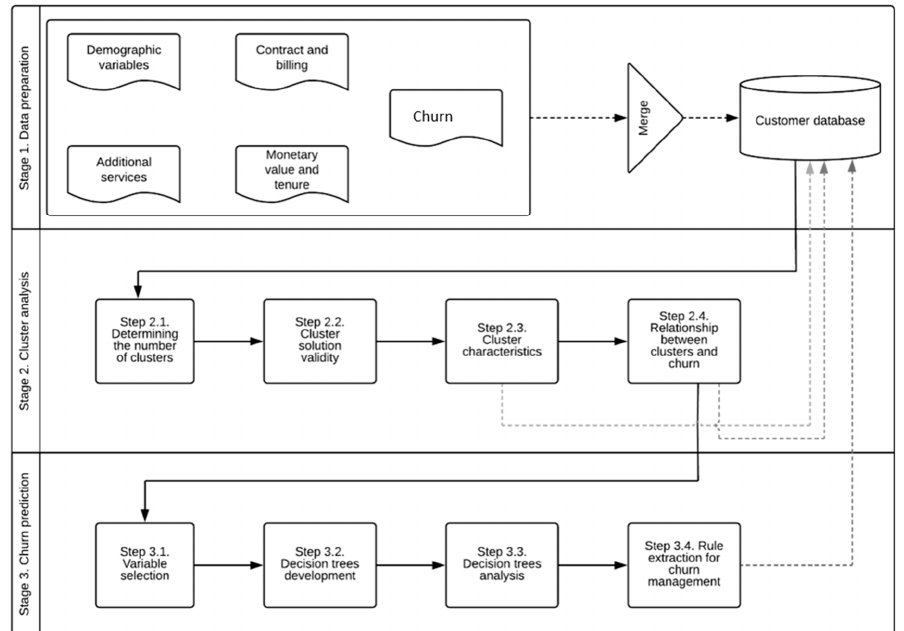
Figure 1. Hybrid methodology for churn analysis. Source: authors’ work using Statistica Software.